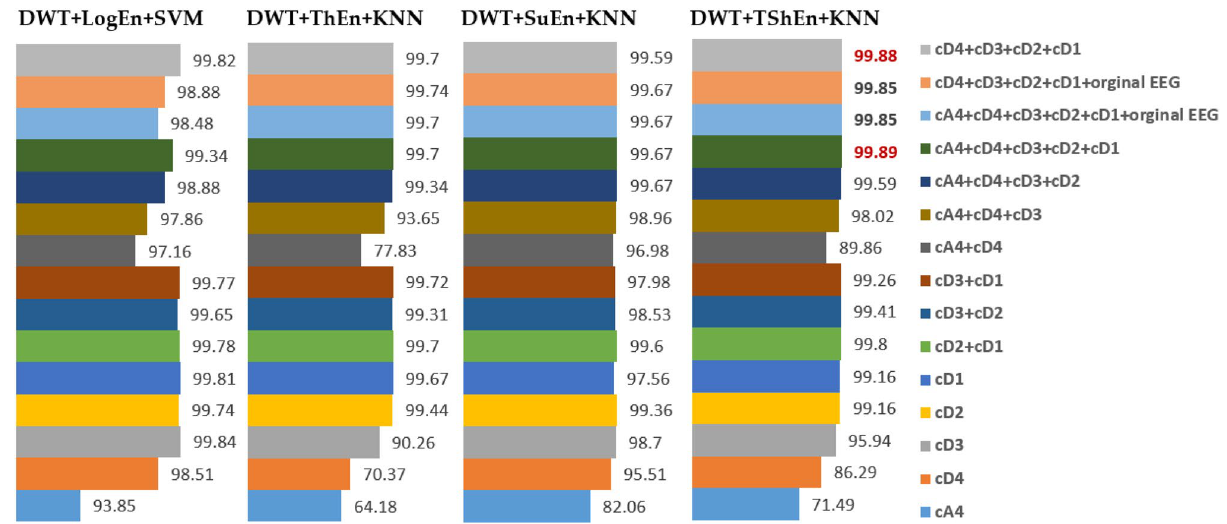
Figure 8. The effect of combination of wavelet coefficients on the classification performance (off-PD vs. HC).